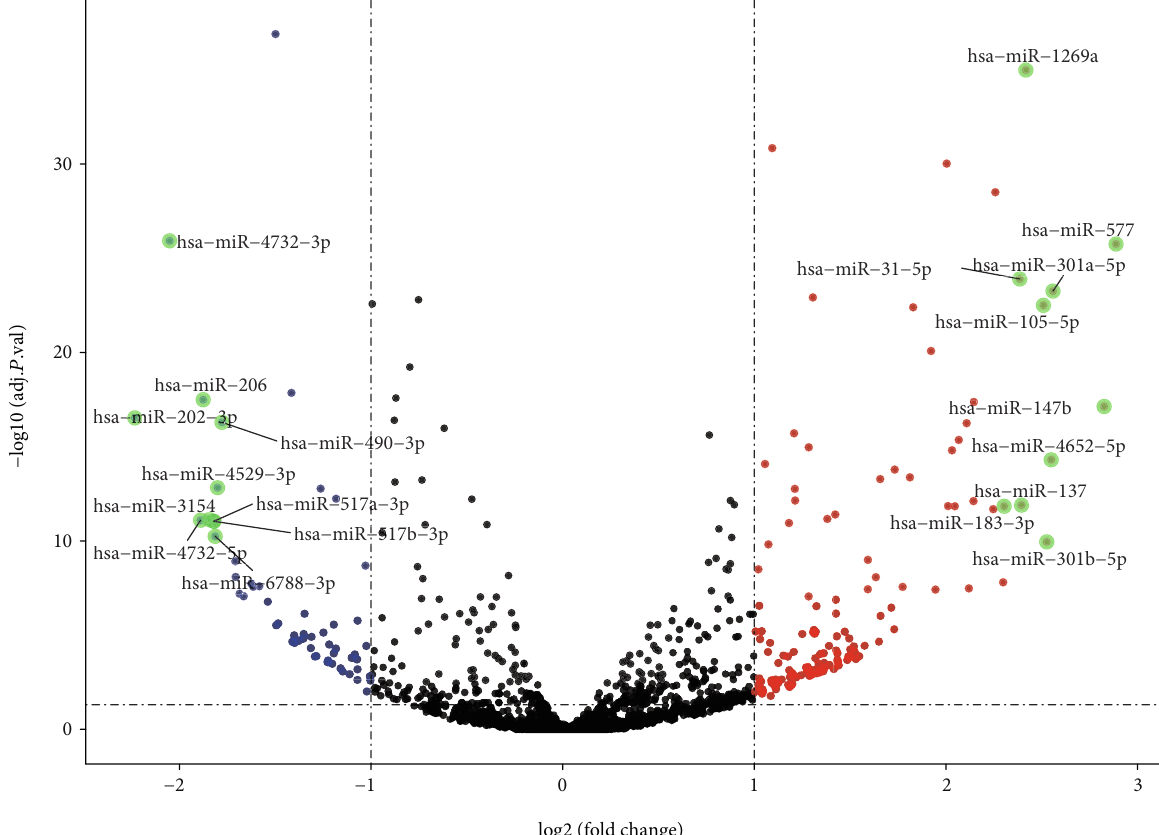
Figure 1: The expression of miRNAs in EC tissues and normal tissues from GEPIA analysis. The top 10 variation miRNAs were marked in the